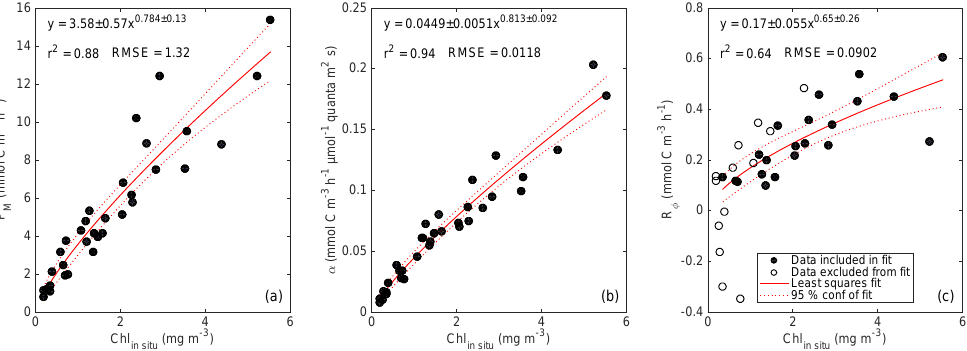
Figure 6. Photosynthetic parameters P m (a) , α (b) , and R (cid:56) (c) vs. in situ Chl a with least squares power-law fits and 95% confidence intervals. R (cid:56) estimates from April and June cruises are excluded from fit (panel c , open